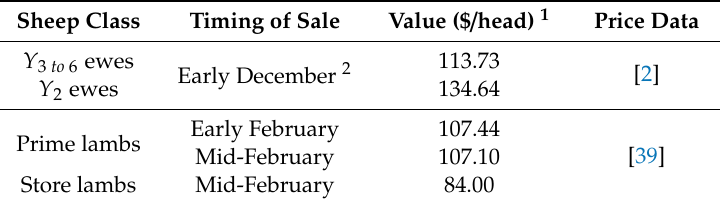
Table 2. Prices for sold sheep, ewes of various age classes (Yi), and lambs sold either prime (direct to slaughter) or store (for another farmer to grow for slaughter).